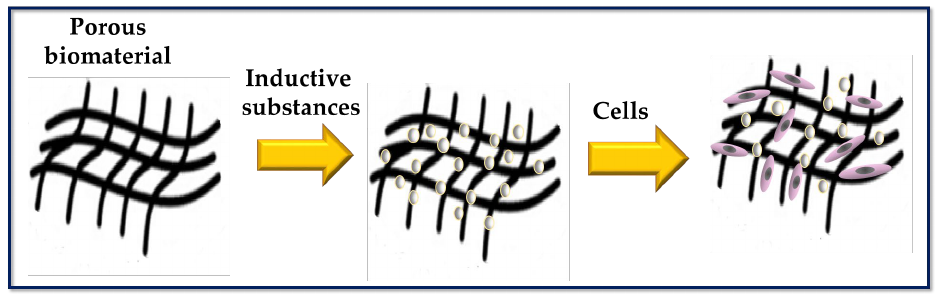
Figure 2. Scheme to represent a porous biomaterial used as a scaffold for tissue engineering. The surface of the scaffold is functionalized with biomolecules capable of inducing cellular responses.